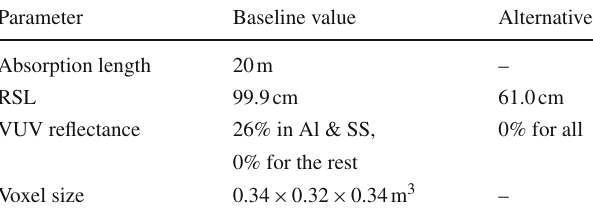
Table5 ParametersofthelightpropagationsimulationinProtoDUNE- DP